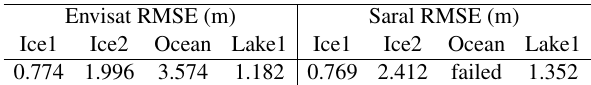
Figure 6: Water level sequence of satellite altimetry points cross- ing Lake Baia Grande (track 220) showing the behaviour of the Ice1 and Lake1 retrackers for both Envisat and